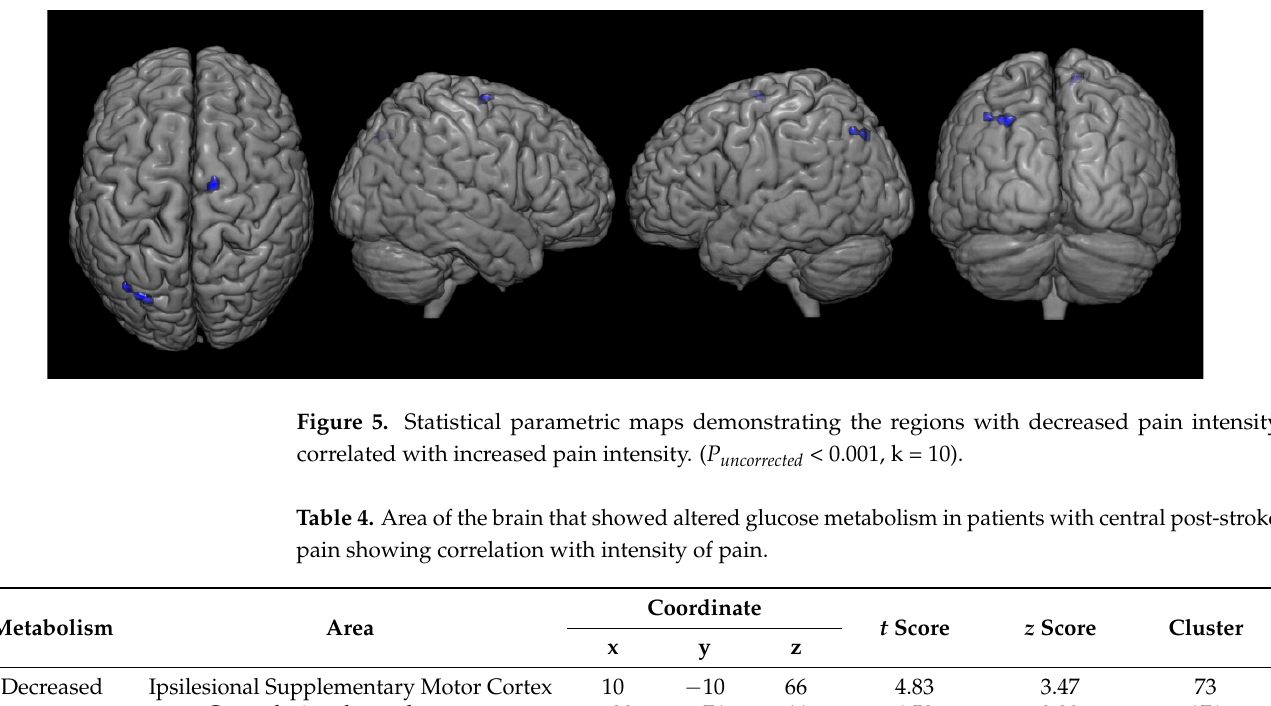
pain showing correlation with intensity of